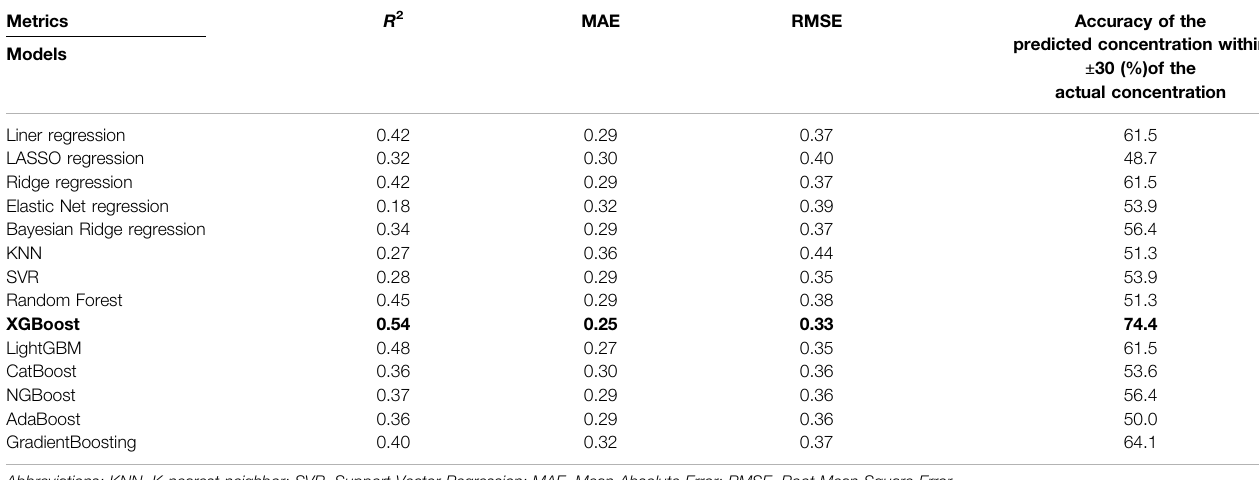
predicted concentration within ± 30 (%)of the actual